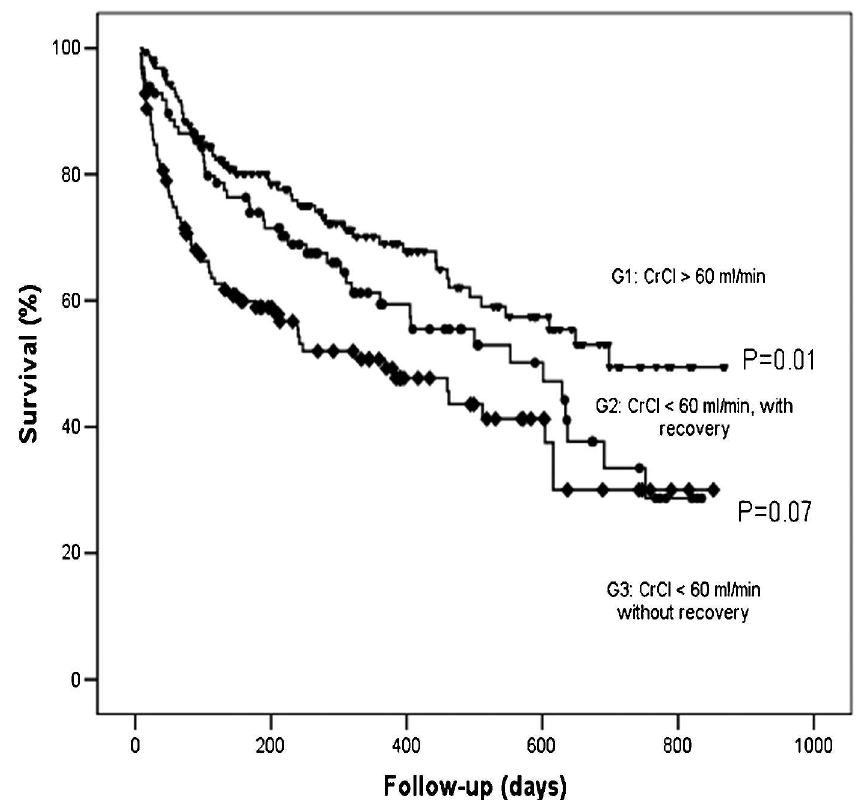
Figure 4 - Survival curves according to renal function evolution. CrCl = creatinine